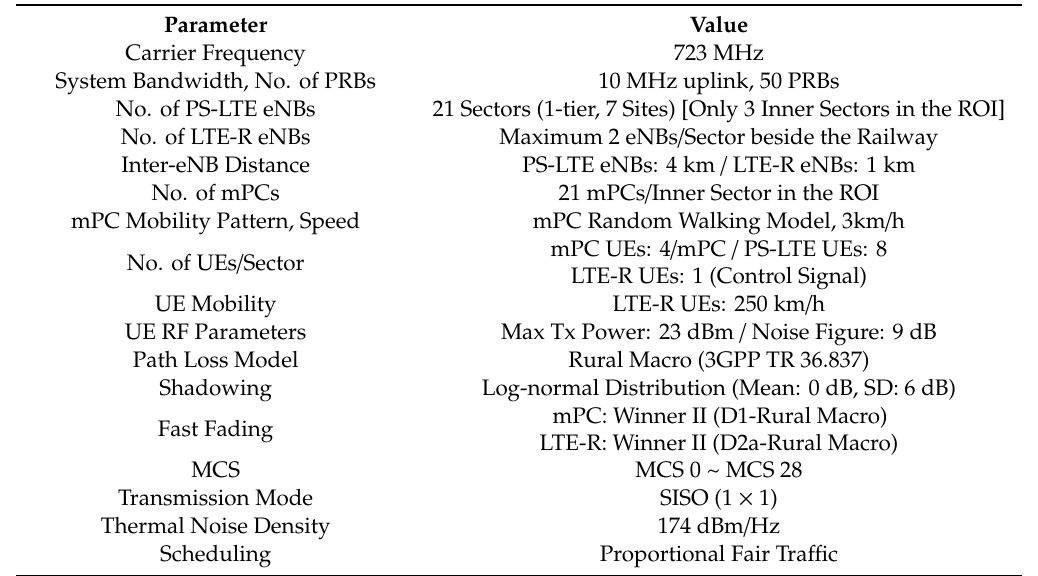
Table 3. System-level simulation parameters.